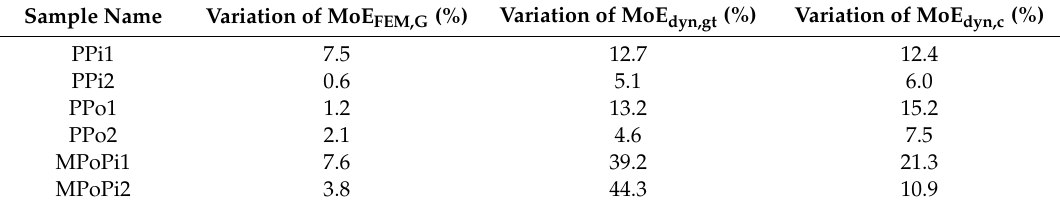
Table 4. Variation in % of the elastic moduli respect to the static modulus MoE st . Comparison of the numerical and experimental moduli of elasticity. MoE st : static modulus of elasticity. MoE FEM,G : calibrated modulus of elasticity using G. MoE dyn,gt : dynamic modulus of elasticity. MoE dyn,c :